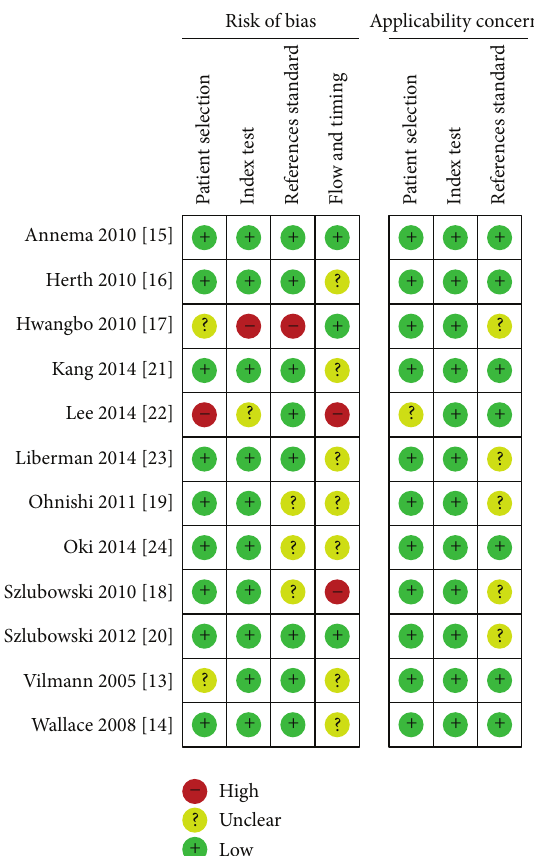
Figure 2: Risk of bias and applicability concerns graph: review of authors’ judgments about each domain presented as percentages across included